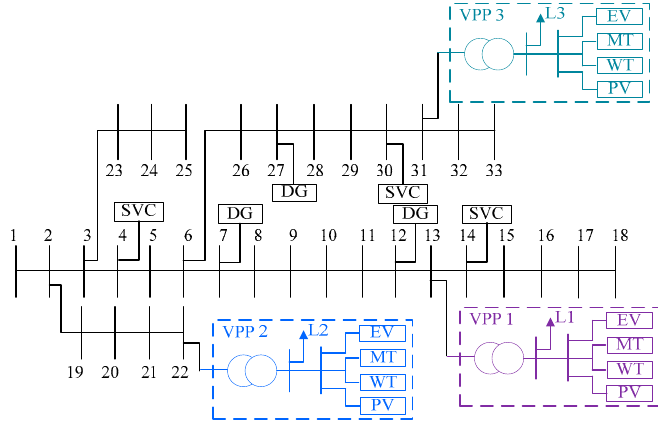
Energies 2018 , 11 , x FOR PEER REVIEW Figure 2. Diagram of ADN system with three VPPs. Figure 2. Diagram of ADN system with three VPPs.